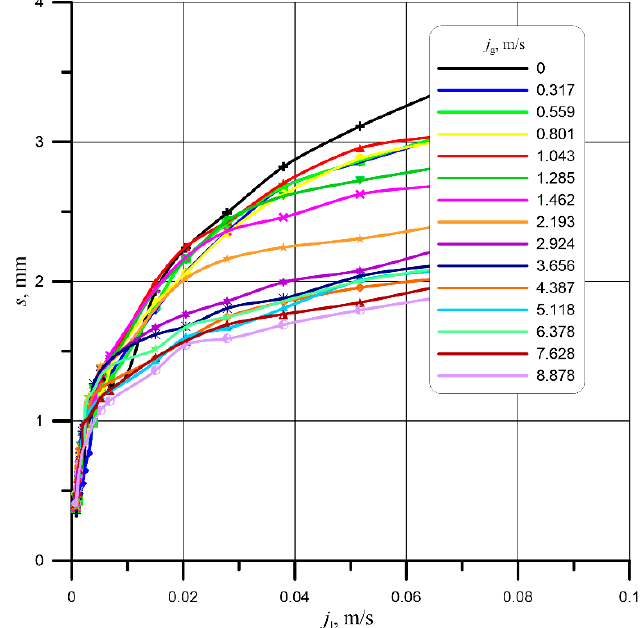
Figure 12. The liquid film thickness in downward two-phase air and oil viscosity η l = 0.371 Pas in pipe d = 0.022 m. Energies 2020 , 13 , x FOR PEER REVIEW